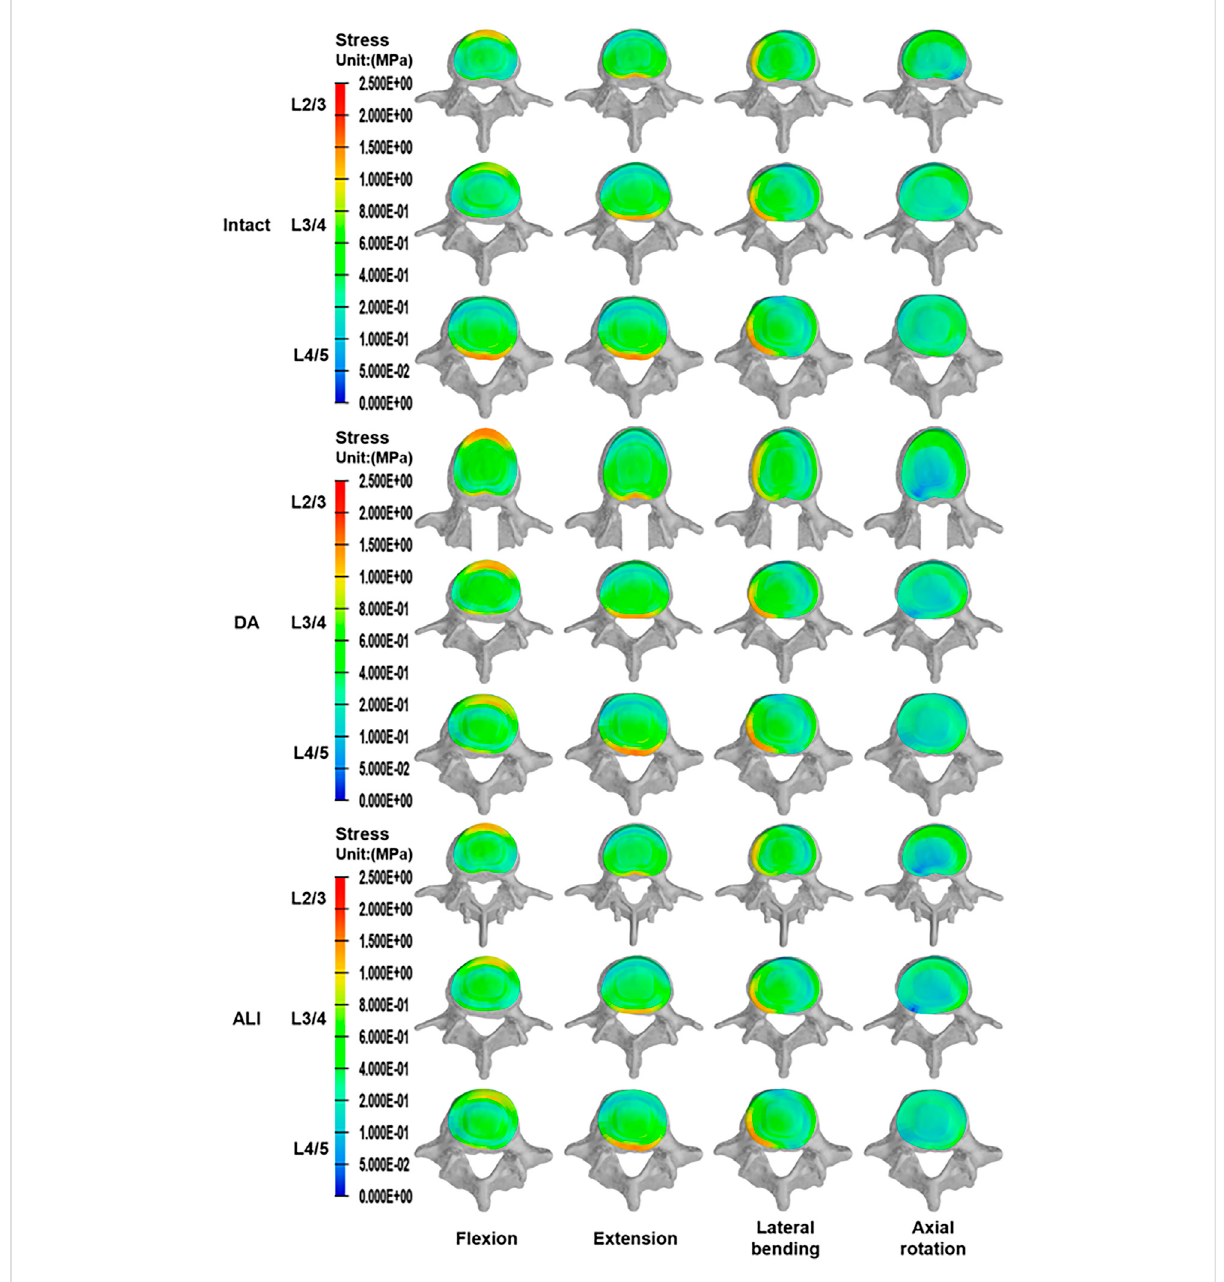
FIGURE 6 The distribution of disc stress at the surgical segment and adjacent